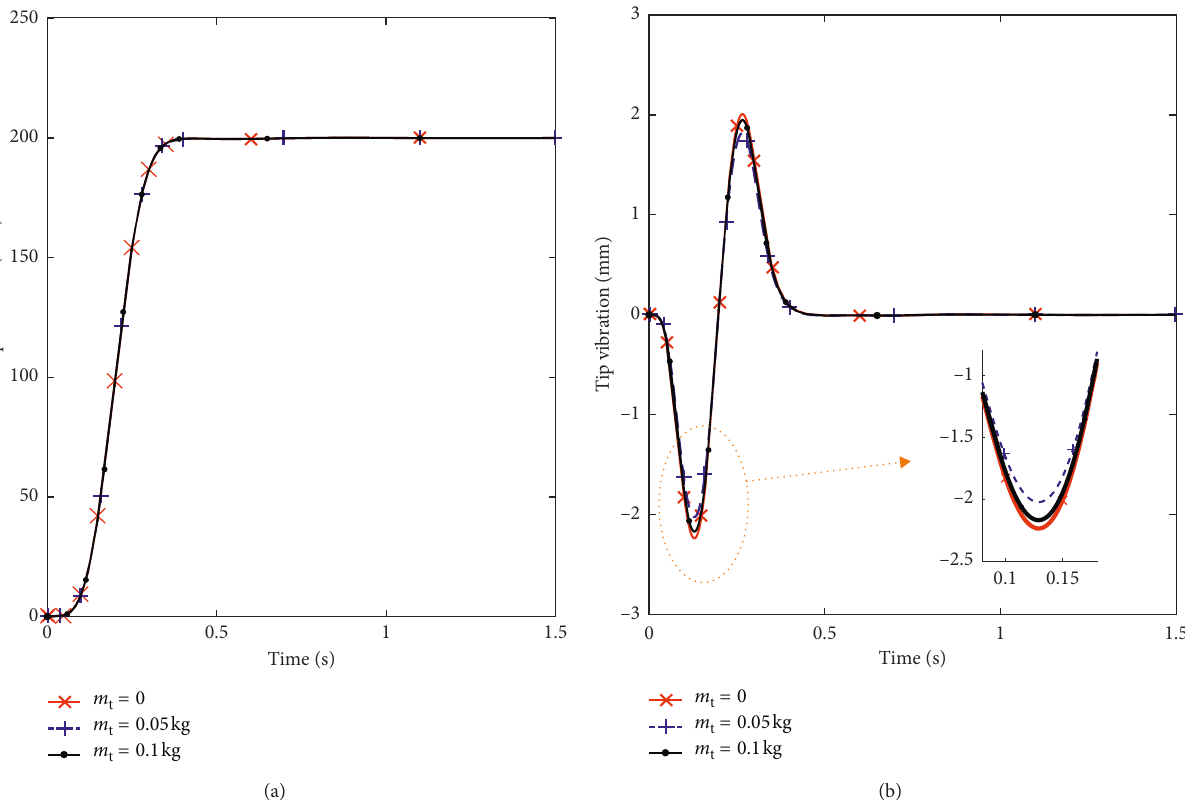
Figure 7: Control effect of the master-slave integrated controller under different terminal loads: (a) control effect of the base displacement; (b) control effect of the tip elastic